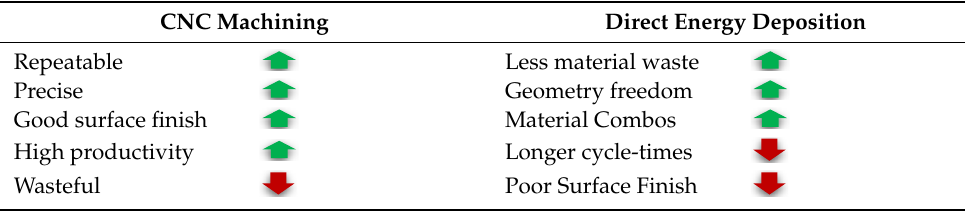
Table 2. Comparison of additive and subtractive processes.